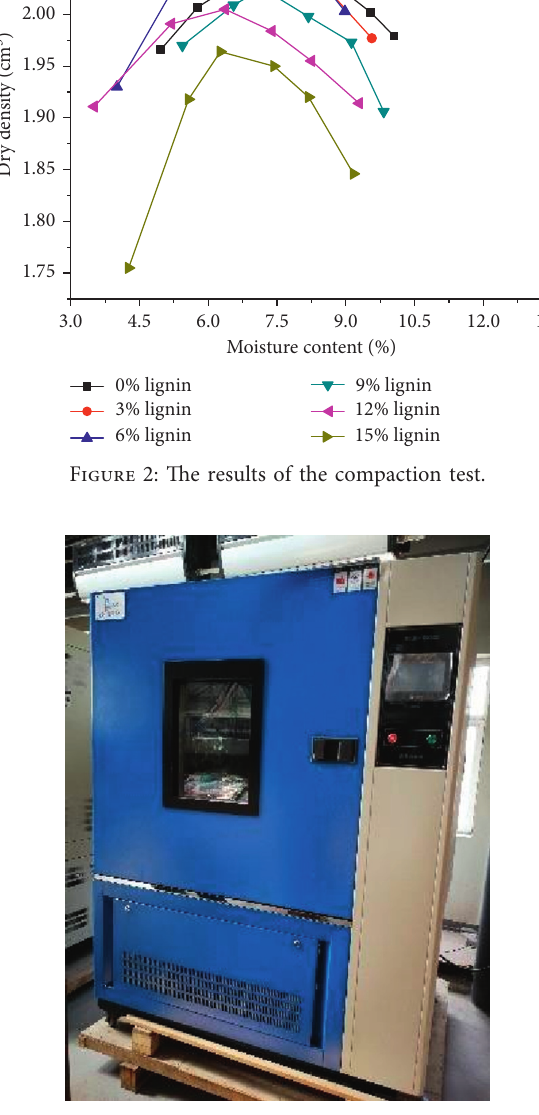
Figure 3: The freeze-thaw